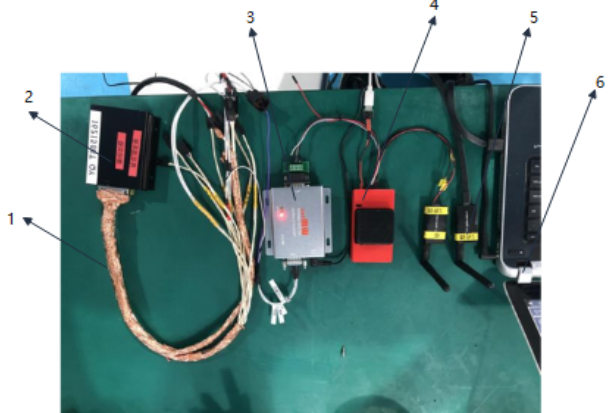
Figure 20. Joint debugging of flight control system and ECU. (1—ECU; 2—ECU harness; 3—RS-232 to TTL photoelectric isolation converter; 4—flight control board; 5—digital transmission platform; 6—ground station).